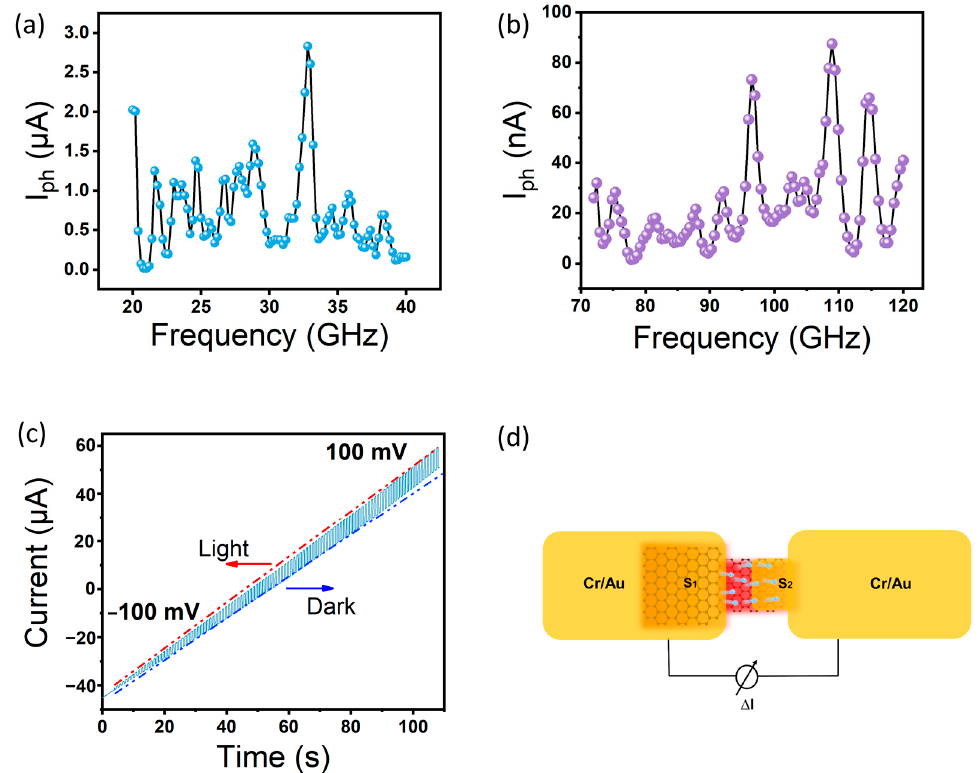
Figure 2. Photocurrent characteristics of the device. ( a , b ) show the frequency-dependent photore- sponse of the device in the range of 0.02–0.04 THz and 0.08–0.12 THz. ( c ) Depicts the photoresponse change under di ff erent THz radiation states (light and dark). ( d ) Illustrates the schematic of the photothermoelectricity e ff ect.